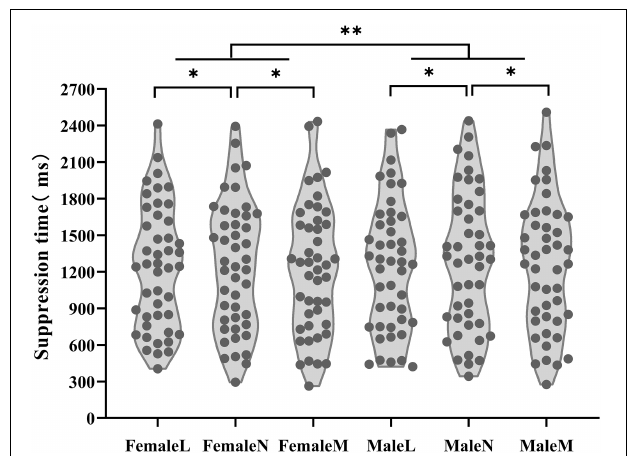
FIGURE 3 | The results of Experiment 1: The plot shows the suppression time of the participants for the least trustworthy, neutral and the most trustworthy faces of different genders (male and female faces). ∗ p < 0.05, ∗∗ p < 0.01. In the figure, FemaleL means the female least trustworthy faces, FemaleN means the female neutral faces, FemaleM means the female most trustworthy faces, MaleL means the male least trustworthy faces, MaleN means the male neutral faces, MaleM means the male most trustworthy